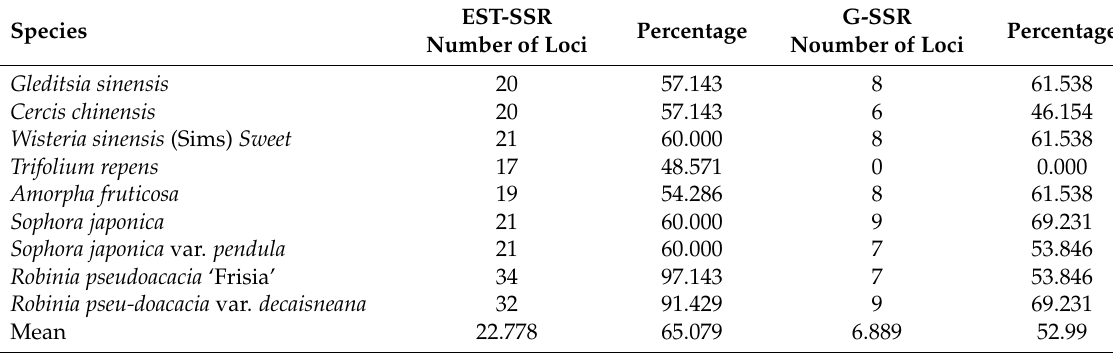
Table 3. Amplification efficiency in Leguminosae species using EST-SSRs and